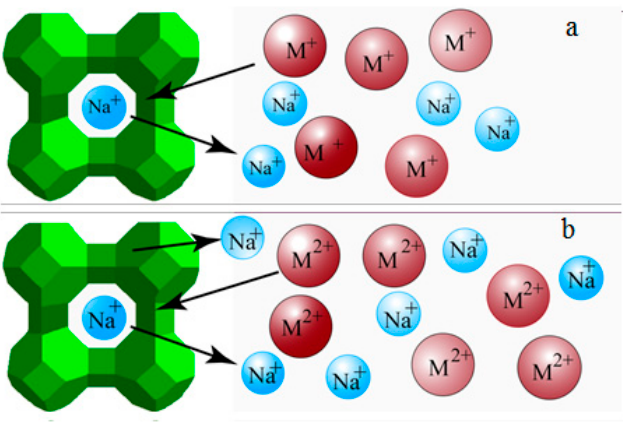
Figure 2. Different cation exchange model of the NaA-Type zeolite. ( a ) Monovalent cation and ( b ) Divalent